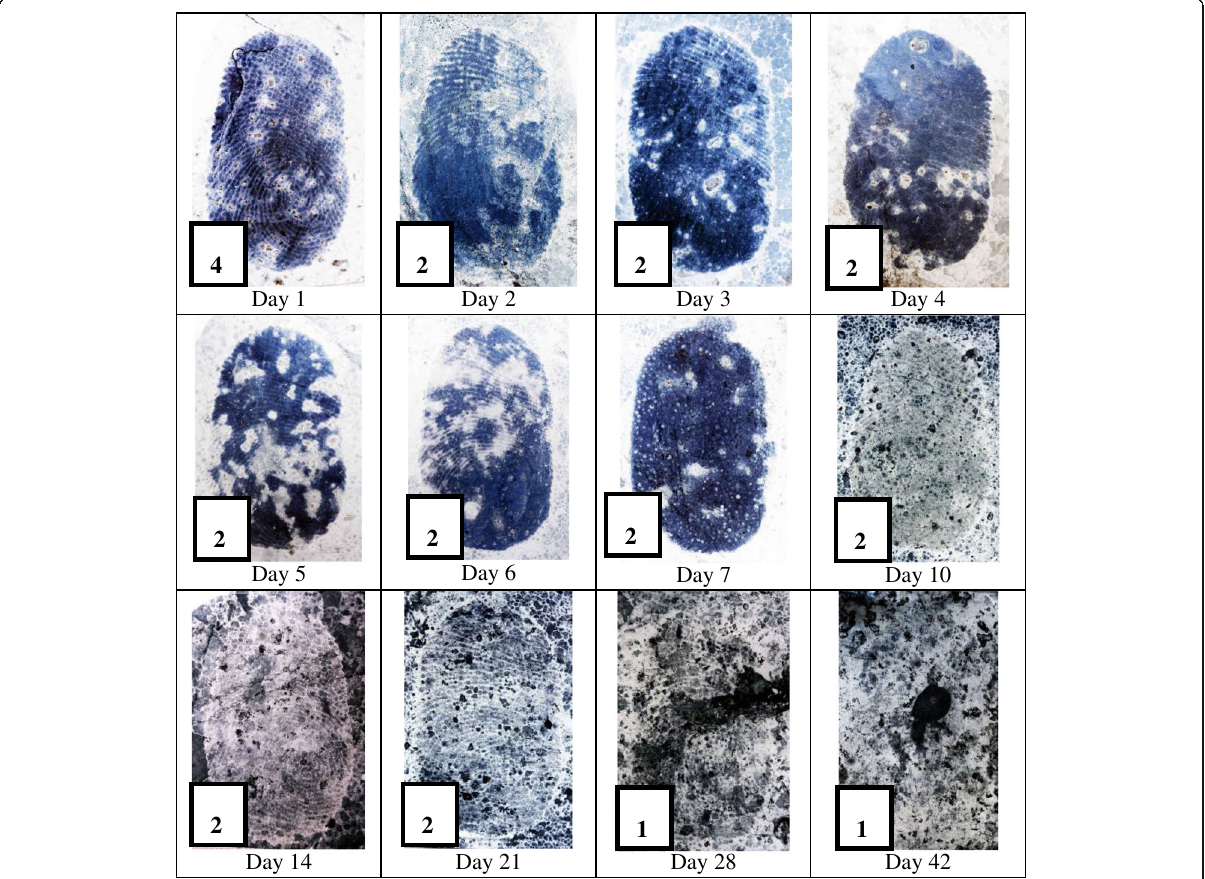
Fig. 16 Fingermarks recovered from the “ face down ” surface of the metal plates from day 1 to day